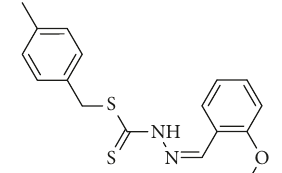
Figure 1: Structure of ligand 1